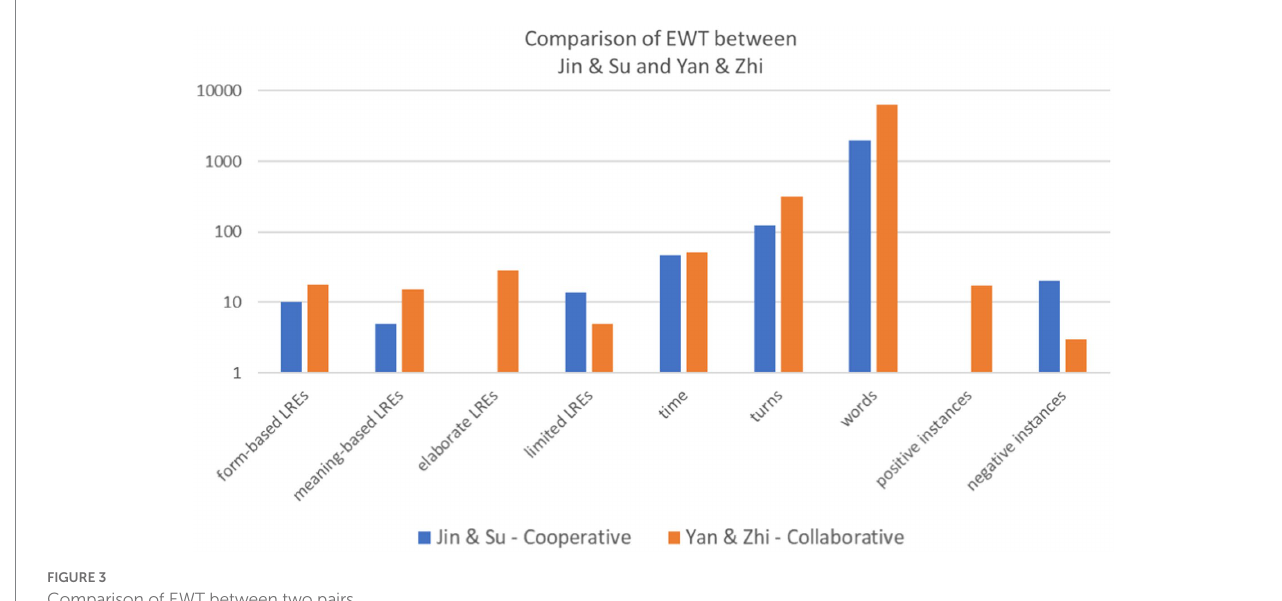
FIGURE 3 Comparison of EWT between two